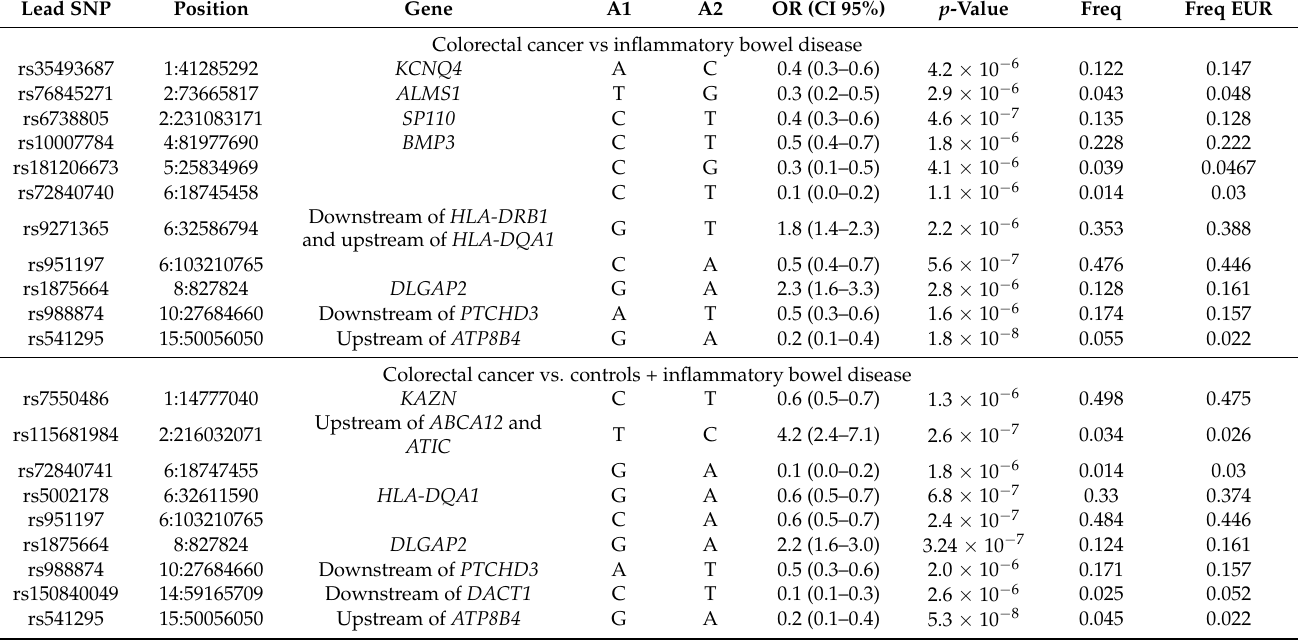
Table 3. Suggestive signals ( p < 5 × 10 − 6 ) detected in the comparison of colorectal cancer and inflammatory bowel disease. Gene, gene where is located the SNP or nearest gene 100kb upstream or downstream from the SNP. OR, odds ratio. CI 95%, confidence interval of 95% of the odds ratio. Freq, frequency of A1 in Basque cohort. Freq EUR, frequency of A1 in European populations of 1